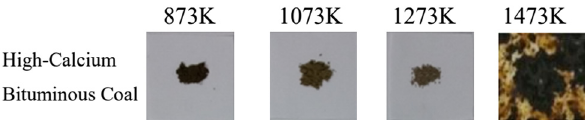
Figure 1: Gray photographs prepared at di ff erent